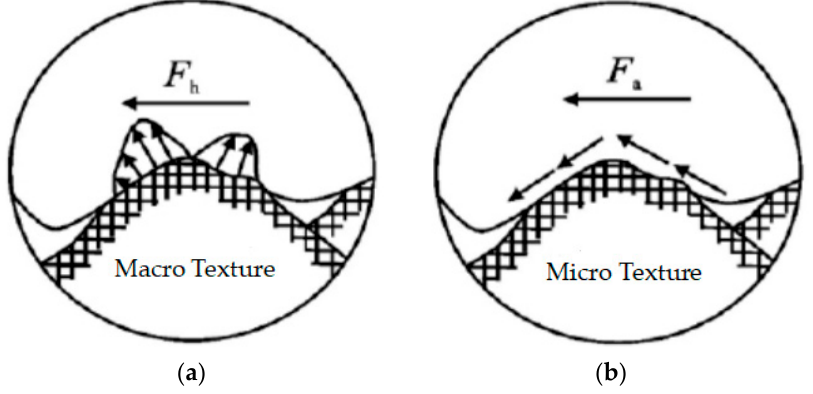
Figure 16. Pictures of tyre textures on two road surfaces. ( a ) Macrotexture; ( b ) microtexture.